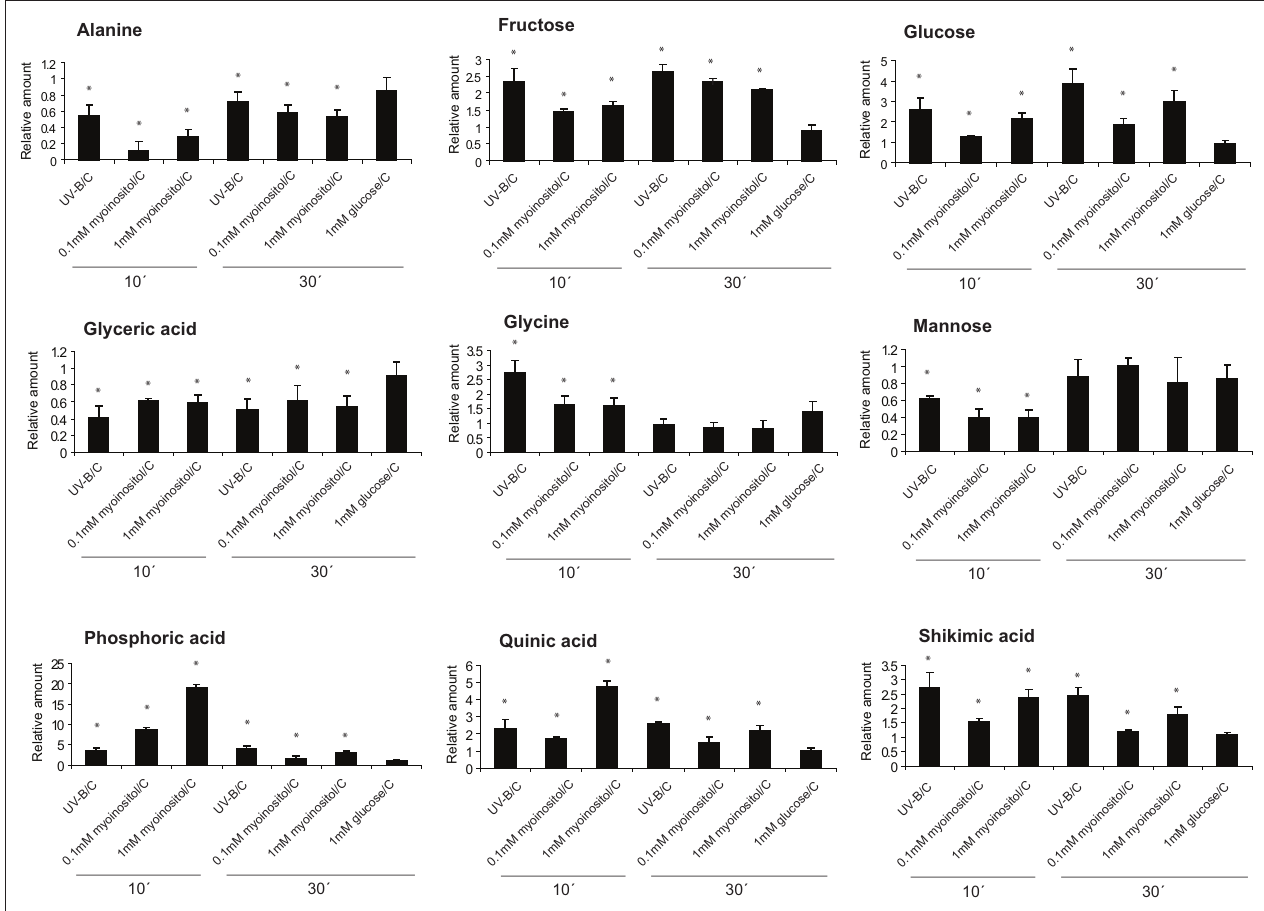
FigURe 5 | effect of myoinositol in UV-B-regulated metabolites. Metabolites changed from maize leaves treated with 0.1 and 1 mM myoinositol compared with a control leaf that was soaked with water; and also after UV-B irradiation for 10 and 30 min. As a control, samples from leaves that were treated with 1 mM glucose were used. Statistical analysis was done using Student T -test; statistically significant differences are labeled with * ( p